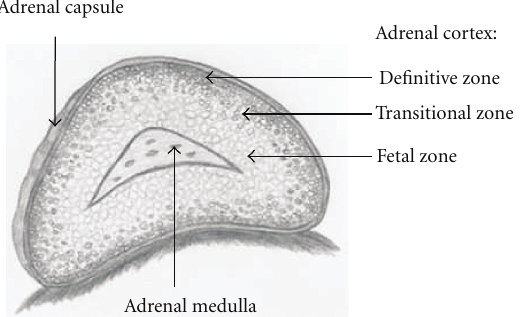
Figure 2: Illustration of the midgestation human fetal adrenal